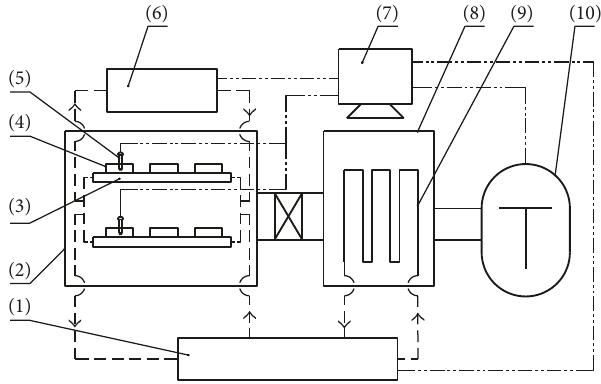
Figure 1: Schematic of the vacuum freeze dryer used. (1) Refrigera- tion machine; (2) freeze-drying chamber; (3) cooling/heating plate; (4) apple slice samples; (5) thermocouple temperature sensors; (6) heating machine; (7) control system; (8) cold trap; (9) refrigeration coils; (10) vacuum